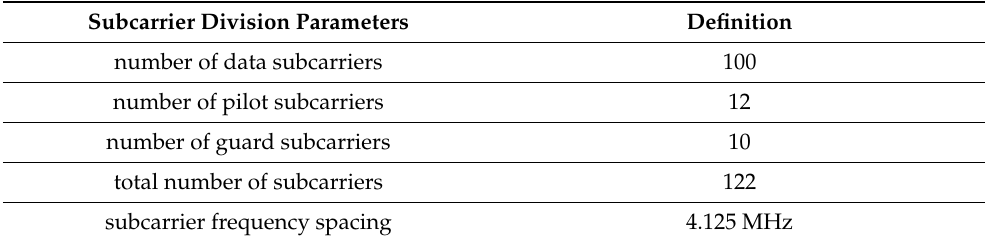
Table 1. Subcarriers of Ku satellite with 500 MHz frequency band. Subcarrier Division Parameters